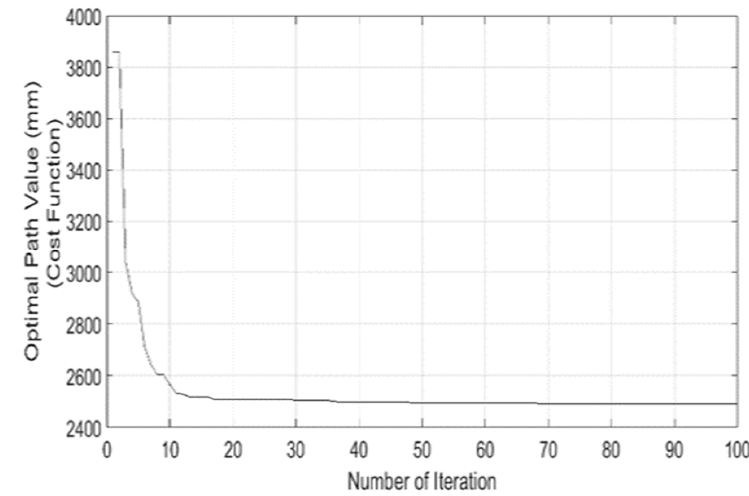
Fig. 8. Best Distance function Founded by GWO Algorithm for Case 2.